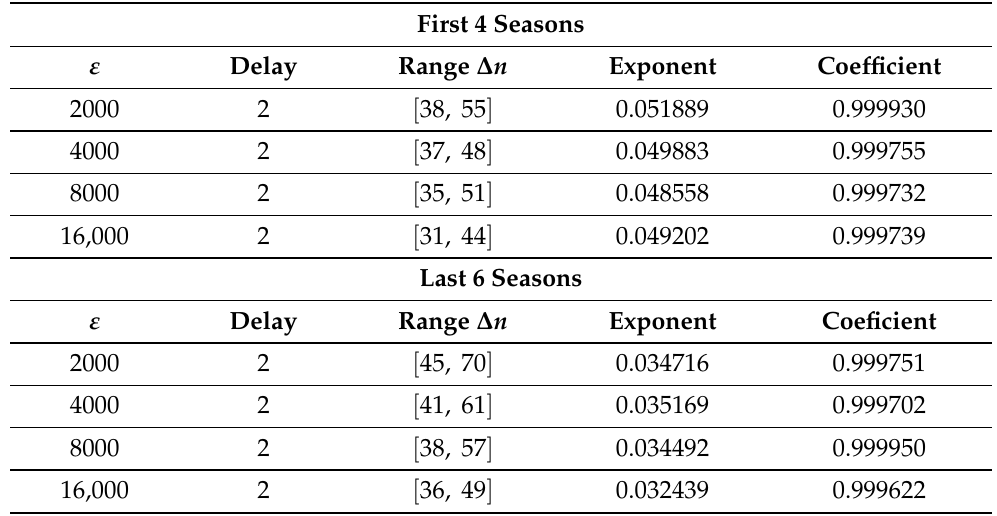
Table 6. Maximal Lyapunov exponents for coop2